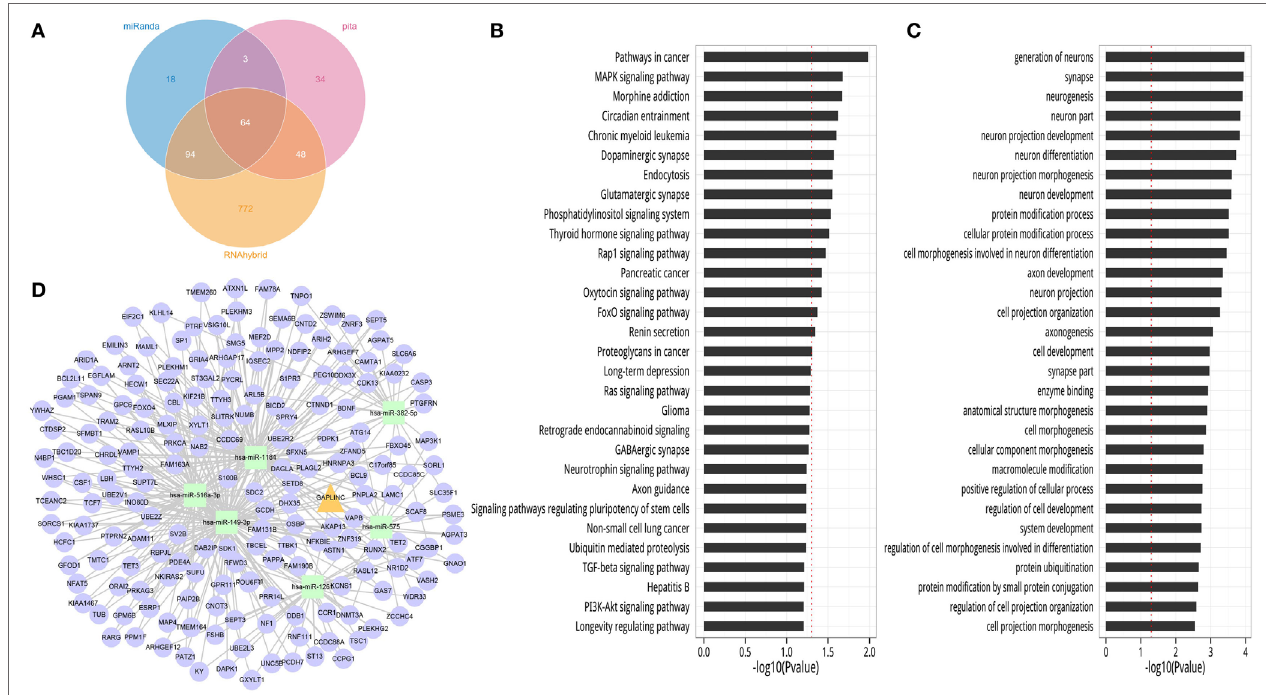
FigUre 4 | The bioinformatics analysis result of GAPLINC sequence. (a) The Venn graph showed 64 candidate microRNAs of GAPLINC in the intersections of miRanda, PITA, and RNAhybrid algorithms. (B) The classification map of KEGG analysis predicted the possible GAPLINC-related pathways. The x -axis is the − log10 of the p -value, and p < 0.05 was considered statistically significant. (c) The distribution map of gene ontology (GO) analysis revealed the possible function of GAPLINC-related genes. The x -axis is the − log10 of the p -value, and p < 0.05 was considered statistically significant. (D) The view of ceRNA module network of GAPLINC based on front six candidate microRNAs (hsa-miR-575, hsa-miR-149-3p, hsa-miR-382-5p, hsa-miR-516a-3p, hsa-miR-1184,